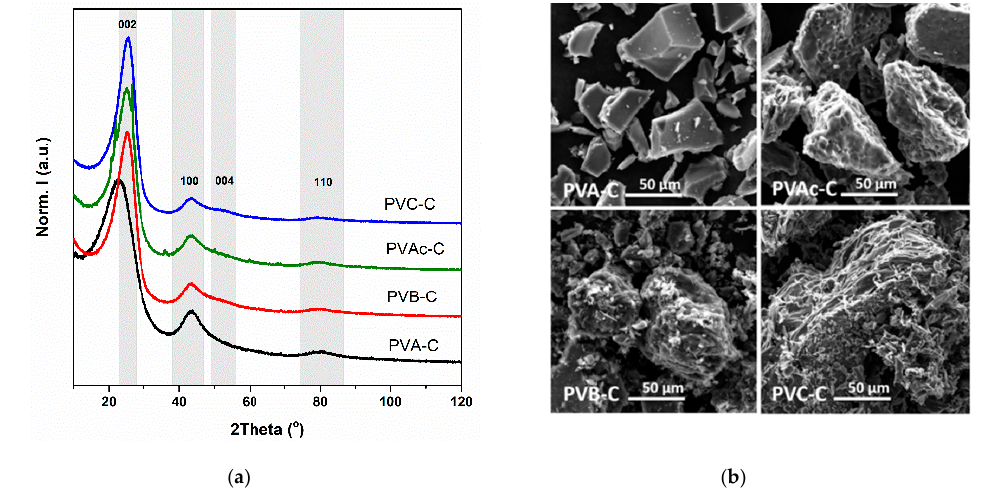
Figure 2. Structural and morphological characterization of the prepared soft carbons: ( a ) PXRD patterns of the pyrolyzed polymers at 800 °C under Ar atmosphere; and ( b ) scanning electron micrographs of various samples at a magnification of 1.2kx. Table 1. The calculated parameters from the fitting of the corrected powder X-ray diffraction (PXRD), shown in Figure S3.